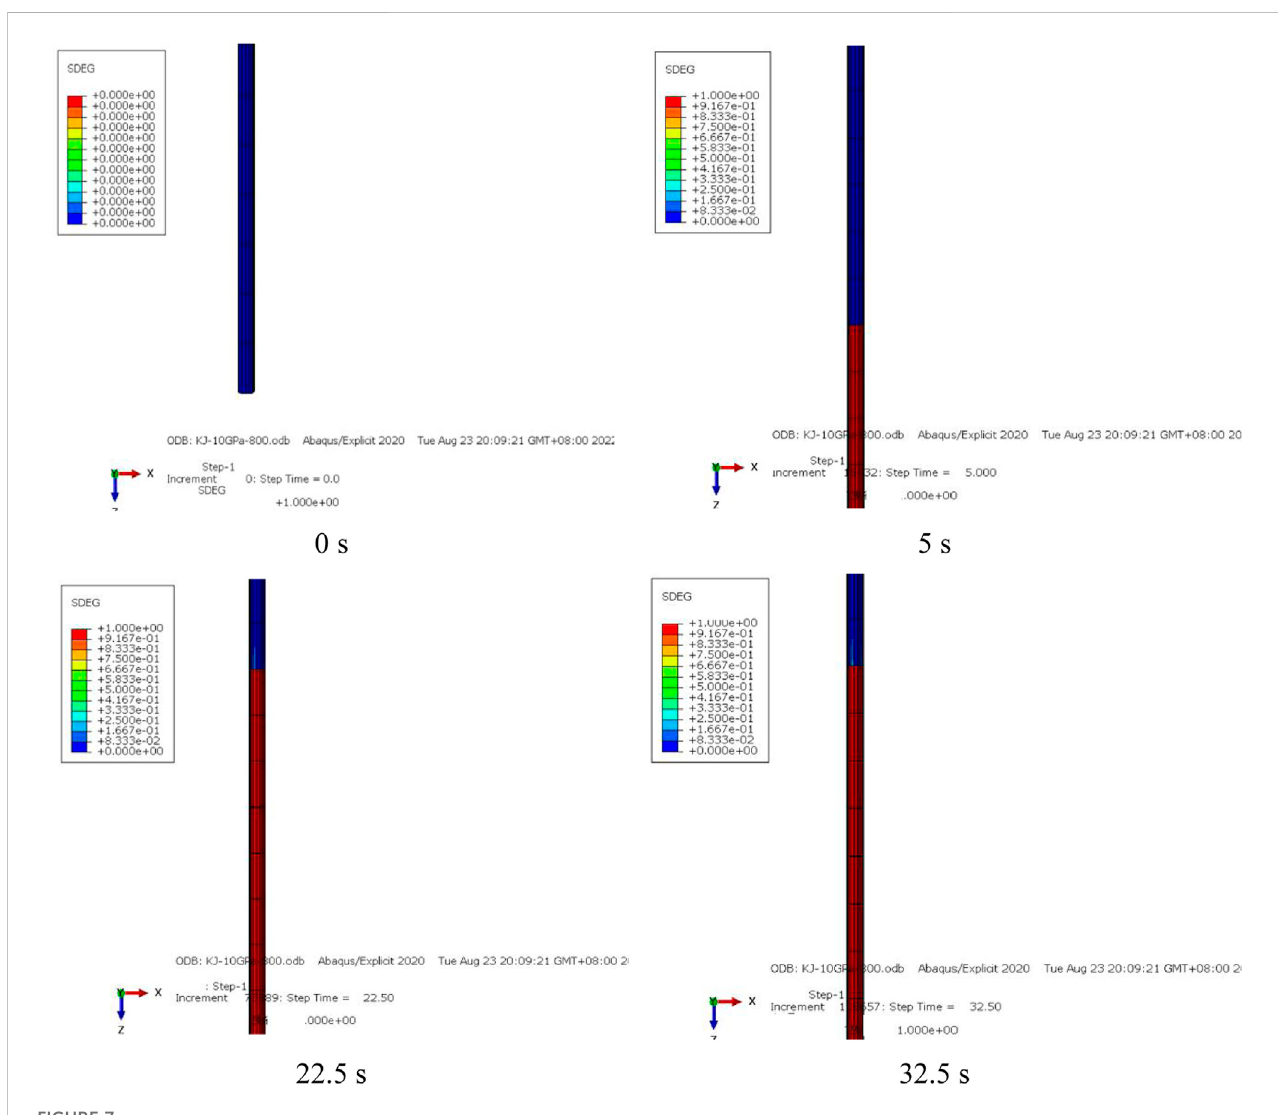
FIGURE 7 Stripping failure length vs. time.